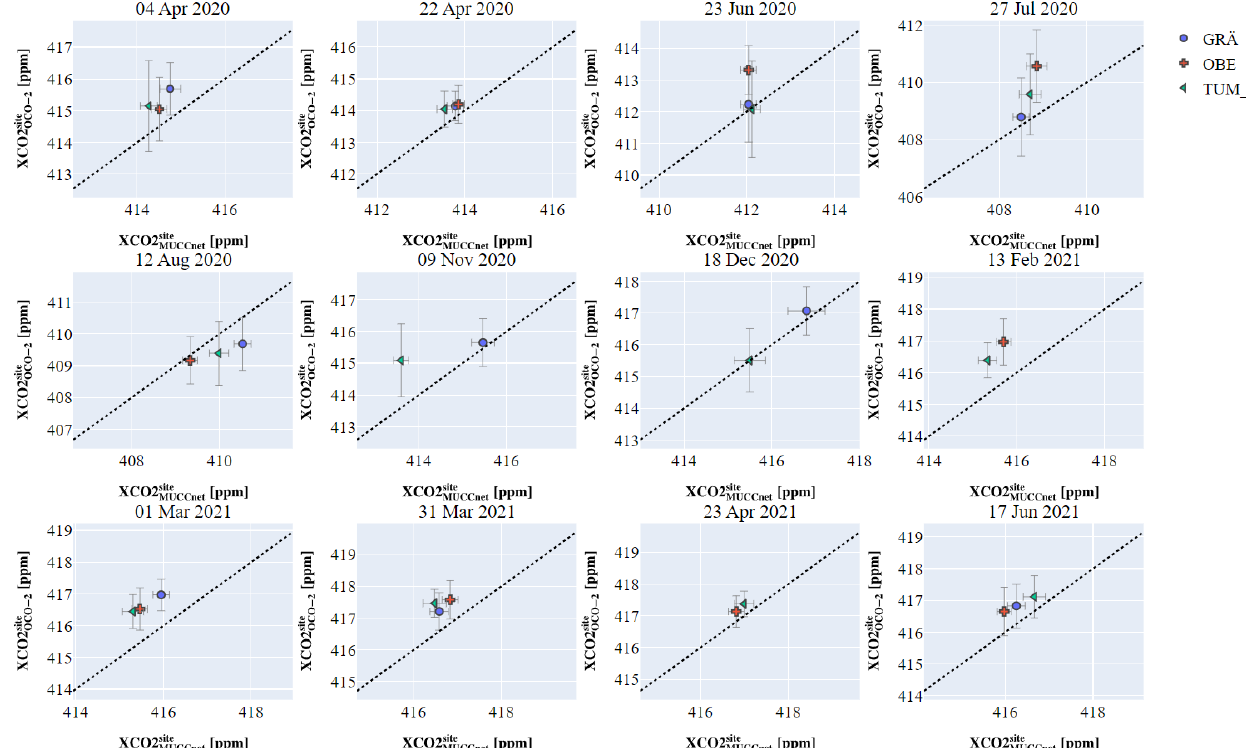
Figure A1. Daily X CO